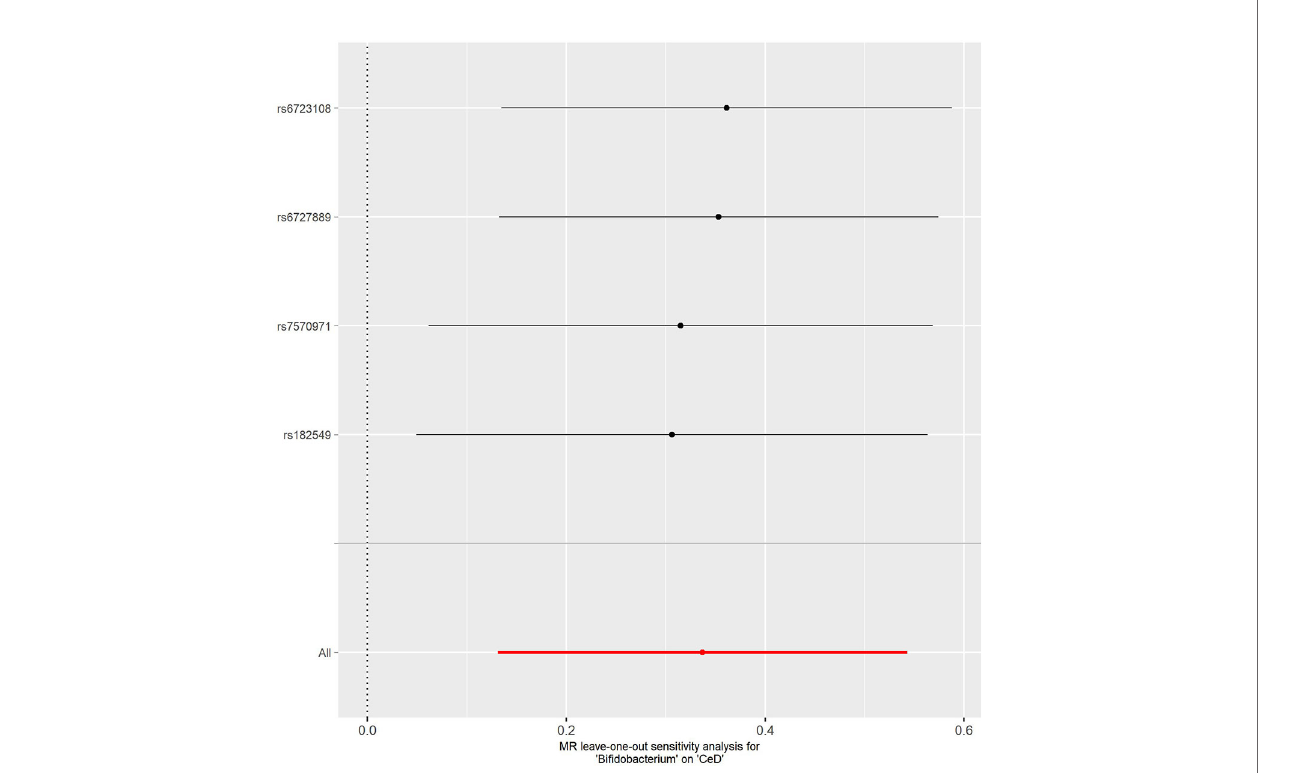
FIGURE 3 | Leave-one-out analysis of the causal effect of Bi fi dobacterium on CeD. Red lines represent estimations from the IVW test. CeD, celiac disease; IVW, inverse variance